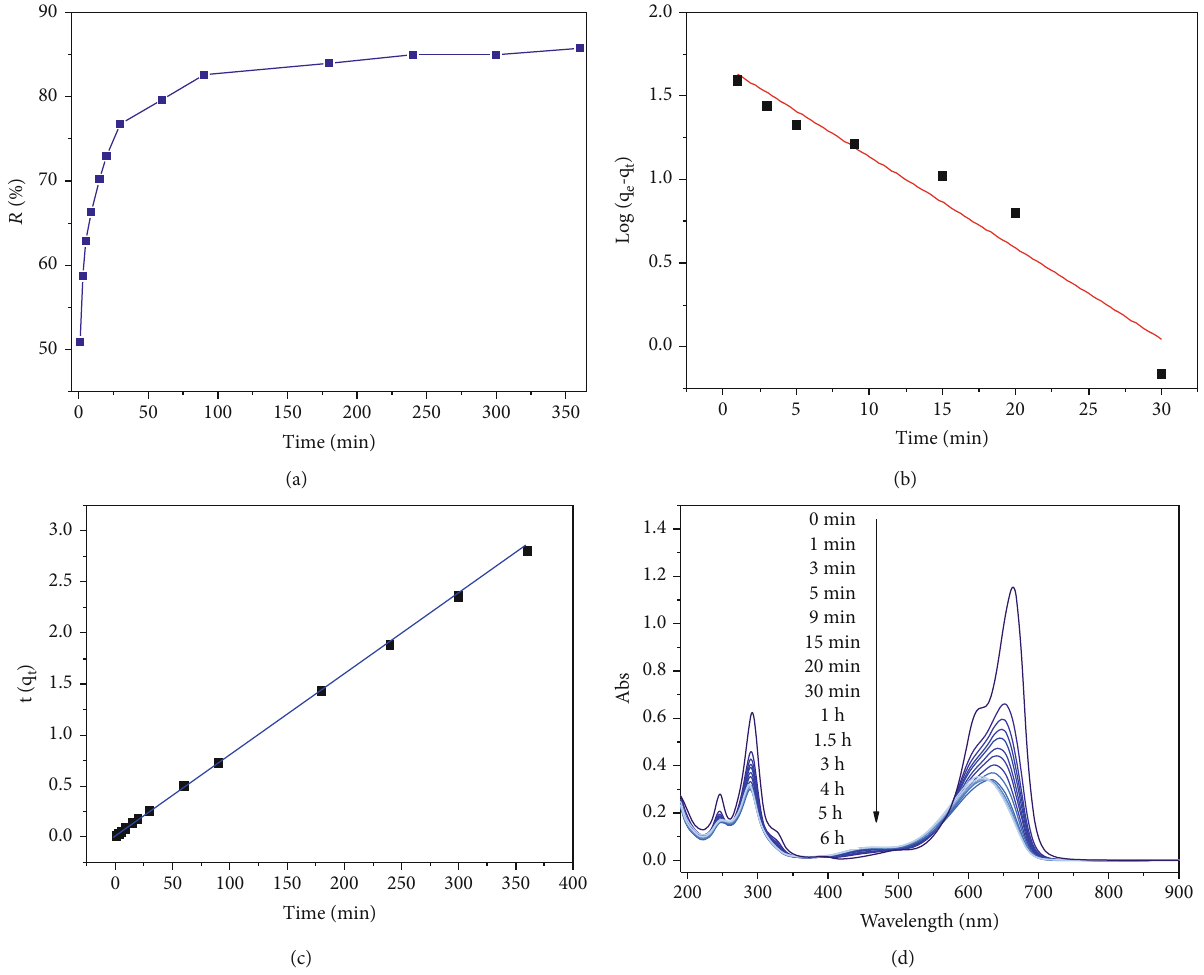
Figure 2: (a) Adsorption capacity as a function of contact time using the (b) pseudo- fi rst-order, (c) pseudo-second-order, and (d) UV-Vis wavelength scan of MB dye.